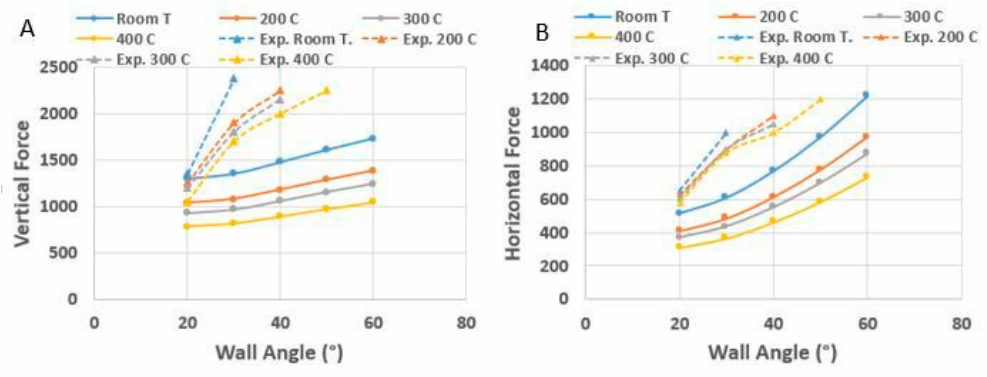
Figure 18. Forces involved in SPIF process; ( A ) vertical forces, Fz; ( B ) radial forces, Fr.